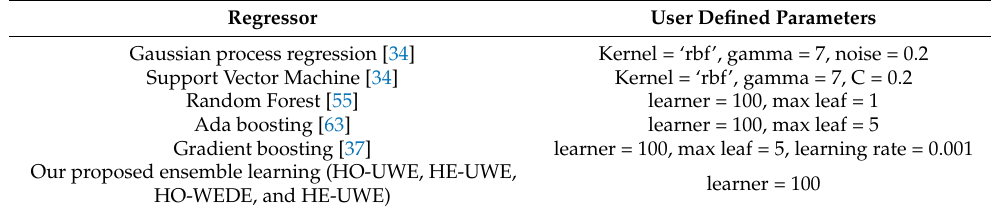
Table 7. Parameter setting.